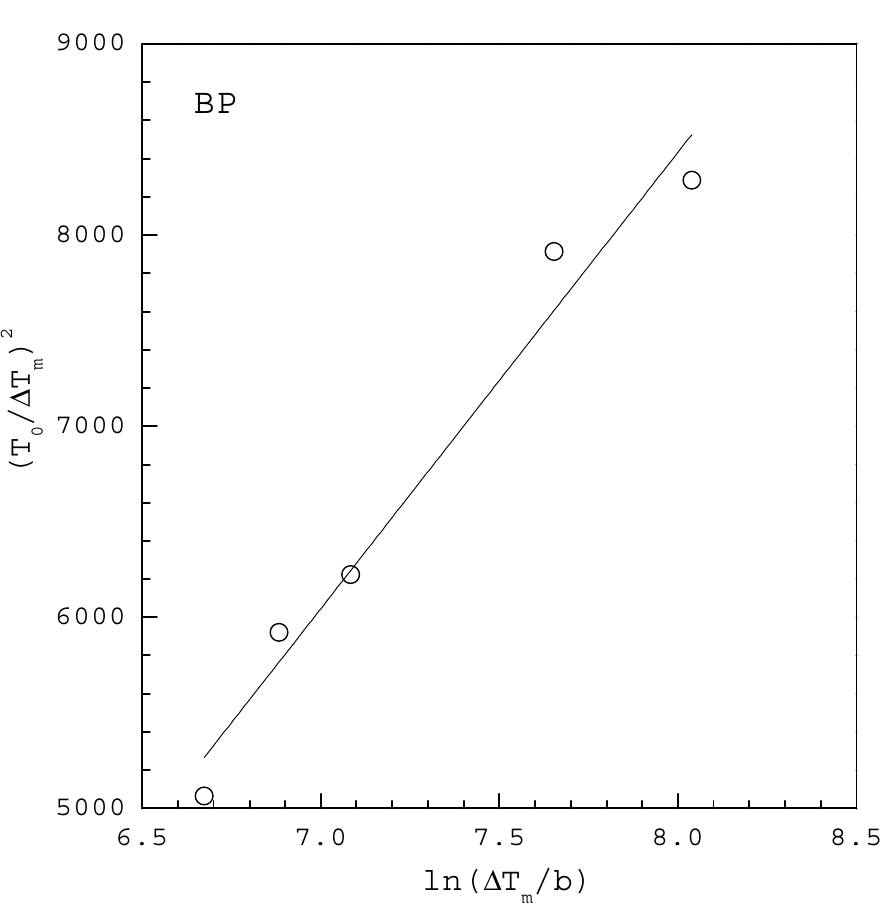
Figure 3 shows the MSZW data fitted to the linearized Equation (11) for BP in 5 mL ethanol saturated at T 0 = 313.15 K, where ∆ T m for each b is extracted at 50% of fraction detected nucleation events from the cumulative distributions of the MSZW data obtained by Yang [26]. The fitting of Equation (11) leads to γ = 0.86 mJ/m 2 and A J = 4588 m − 3 s − 1 with R 2 = 0.961 in Table 1. Note that v m = 2.57 × 10 − 28 m 3 for INA. According to the solubility reported by Yang and Rasmuson [27], ∆ H d = 11.9 kJ/mol is used for the van’t Hoff solubility equation. For comparison, Table 1 also lists γ = 1.15 mJ/m 2 and A J = 2752 m − 3 s − 1 reported by Yang and Rasmuson [23] for BP in 5 mL ethanol using the cumulative distributions of the induction time data fitted to Equation (4).